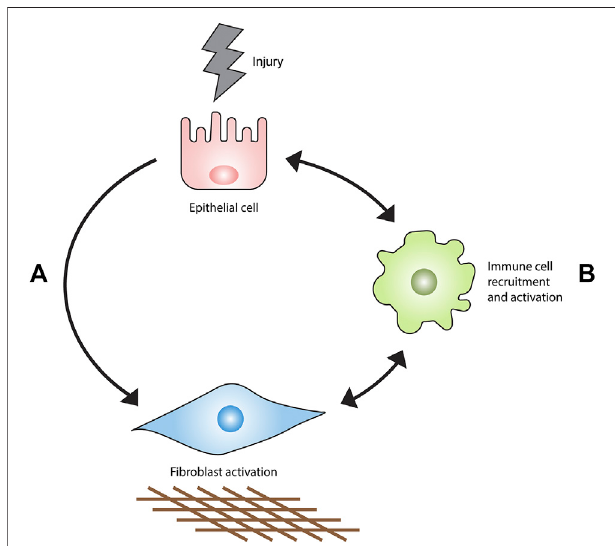
FIGURE1| CurrentmodelofIPFpathogenesis.Epithelialinjuryresultsin fi brosis primarily through an interaction with fi broblasts (A) rather than the recruitment and activation of immune cell populations (B) . Immune cells accumulate in the injured lung and orchestrate the development, maintenance, progression or regression of fi